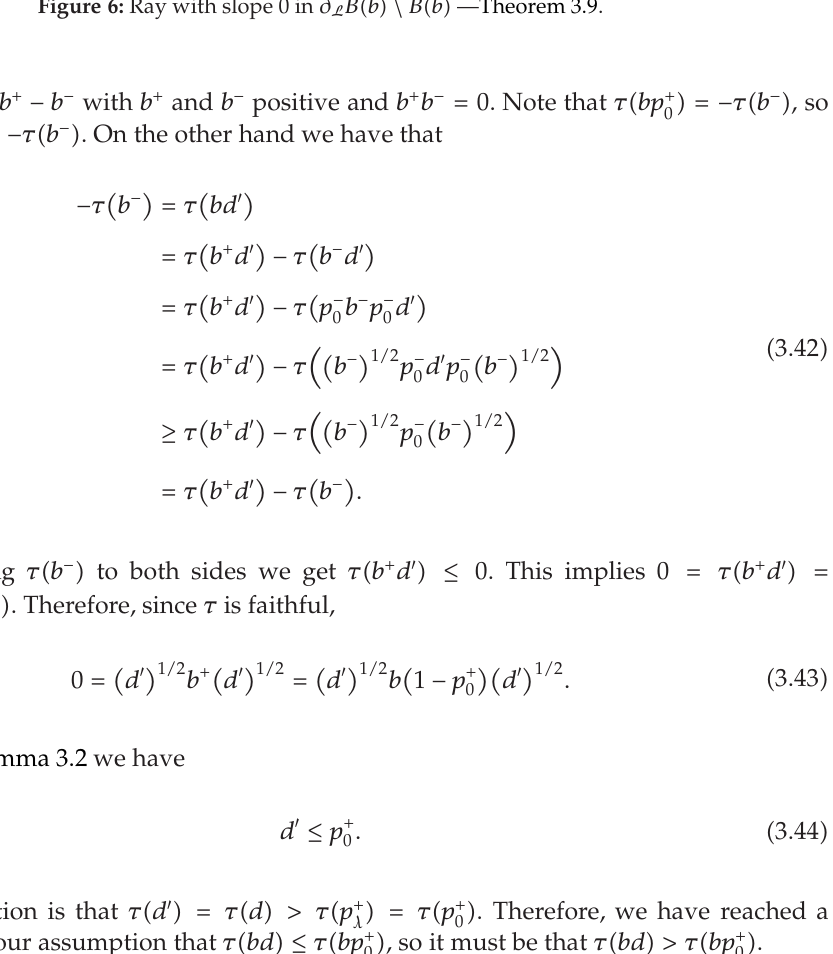
Figure 6: Ray with slope 0 in ∂ L B (cid:2) b (cid:3) \ B (cid:2) b (cid:3) —Theorem